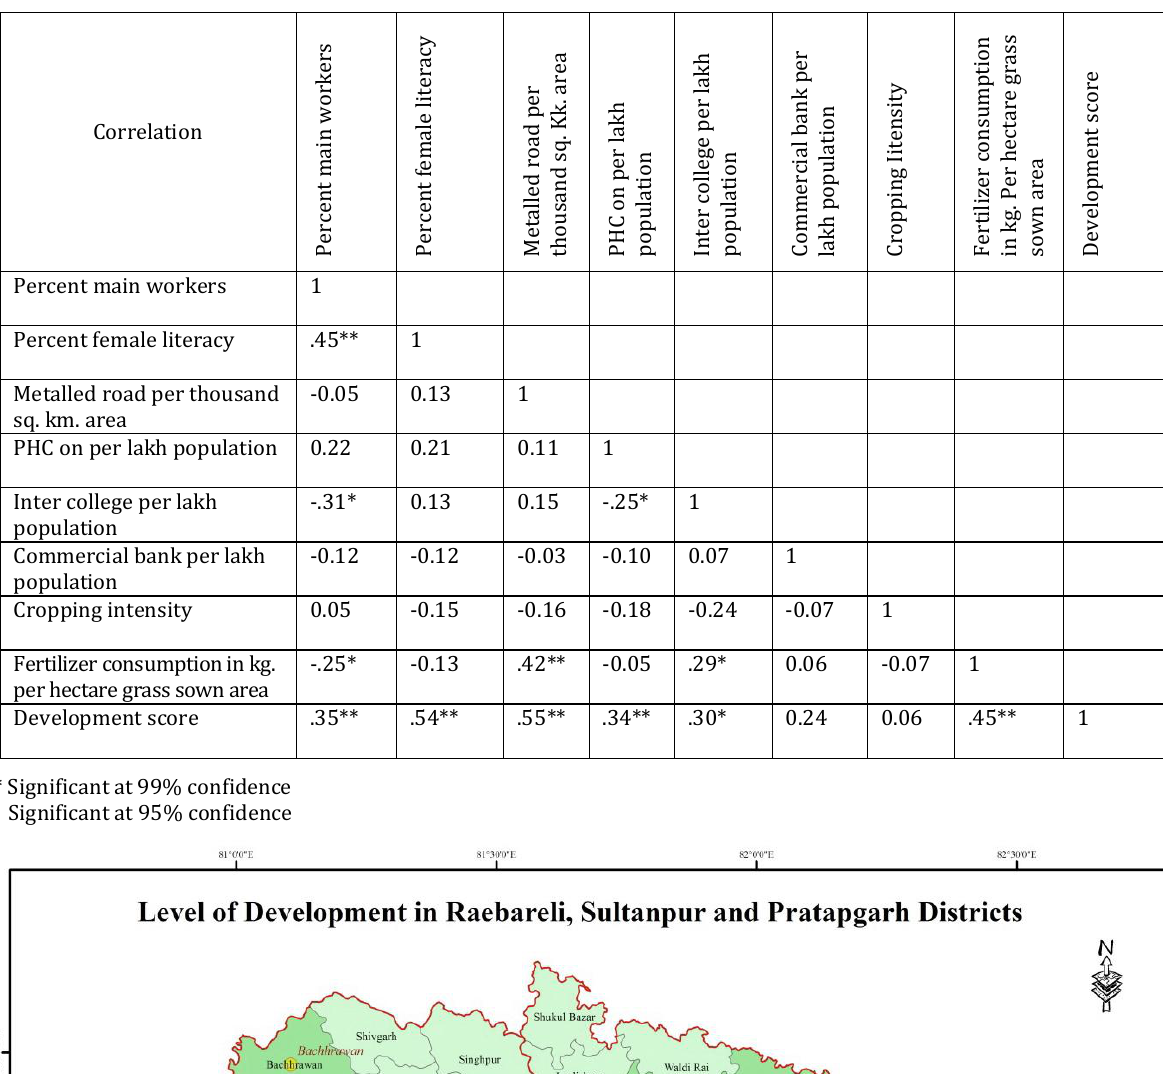
Table 2. Correlation matrix between variables and the development score (Source: computed)